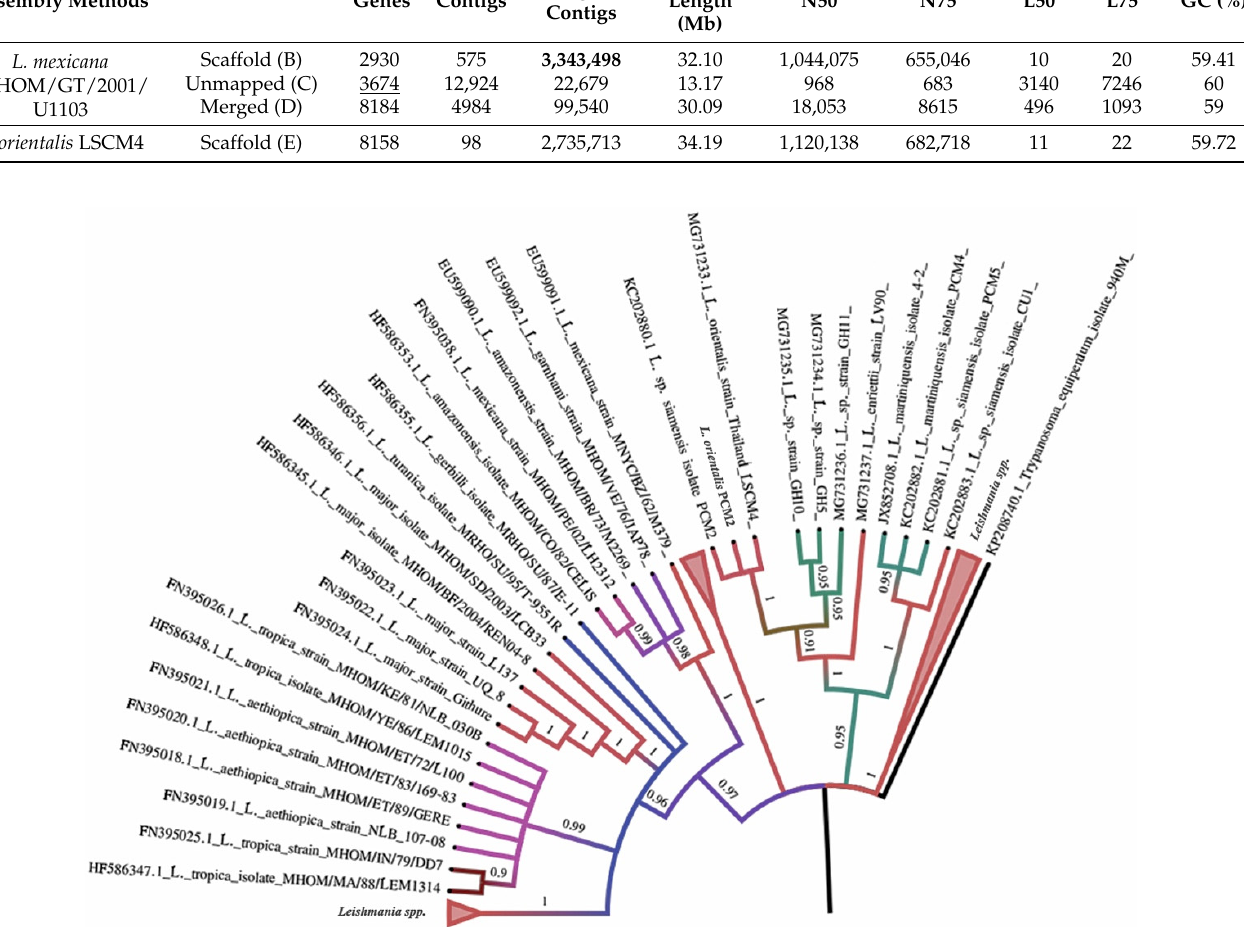
Figure 2. Phylogenetic relationship of Leishmania species reconstructed based on the heat shock protein 70 (hsp70) gene using the neighbour-joining method with the p -distance model and 10,000 bootstrap iterations. Line colours represent clusters of the samples. The branch number indicates the bootstrap value. The red triangles represent the distant clades which included sequences of Leishmania infantum (123 samples), Leishmania donovani (91 samples), Leishmania braziliensis (90 samples), Leishmania tropica (38 samples), Leishmania major (31 samples), Leishmania turanica (10 samples), Leishmnia naiffi (9 samples), Leishmania chagasi (6 samples), Leishmnia aethiopica (6 samples), Leishmania sp. (5 samples), and Leishmania panamensis (4